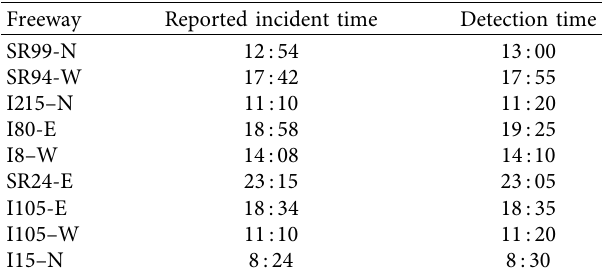
Table 5: Comparison of incident time and detection time.